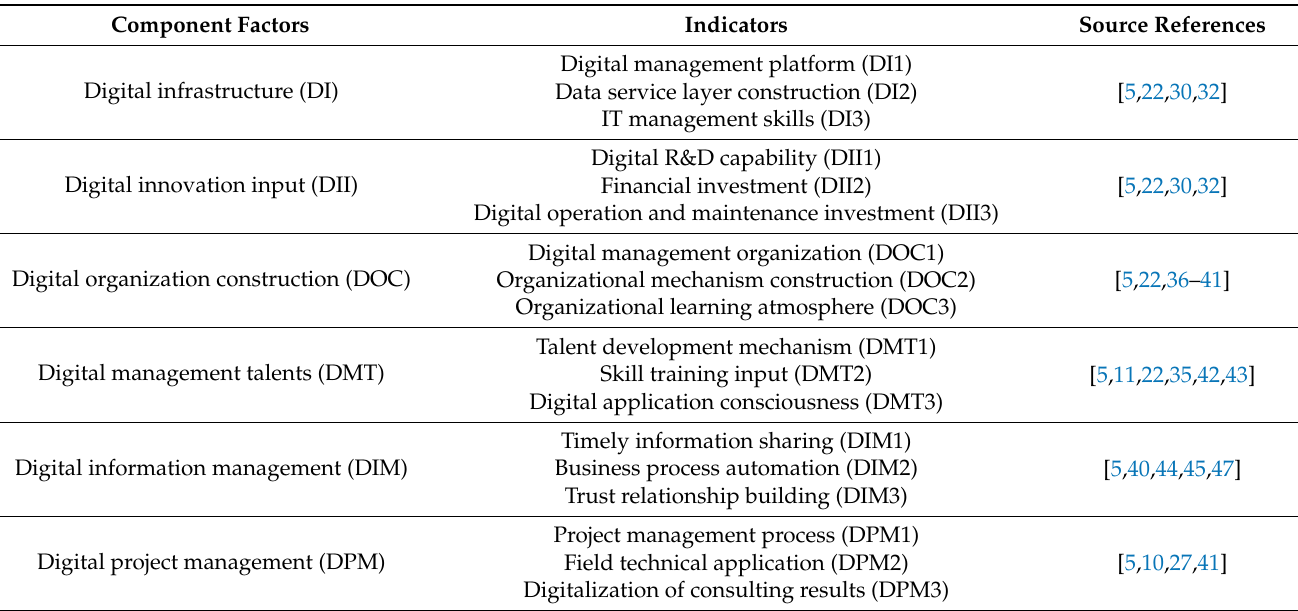
Table 2. Sources of measurement items.